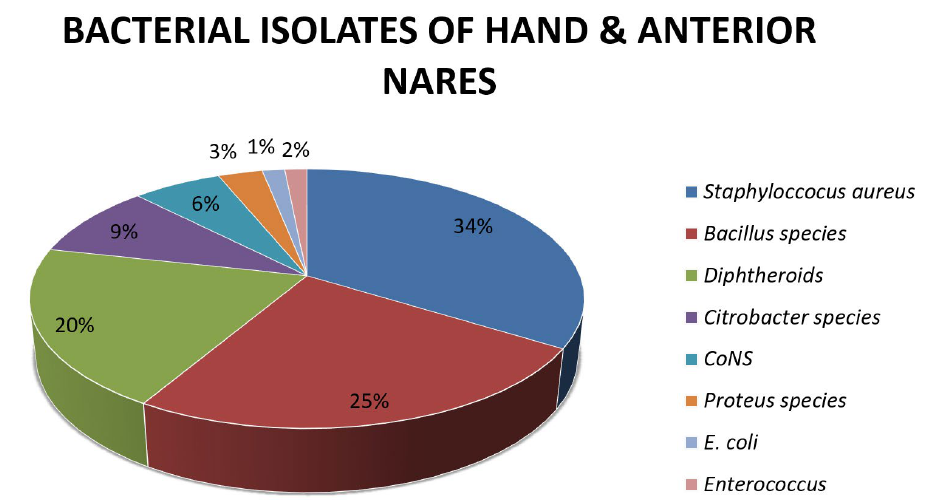
Fig. 4. Cumulative data on bacterial isolates obtained from hand and anterior nares of food